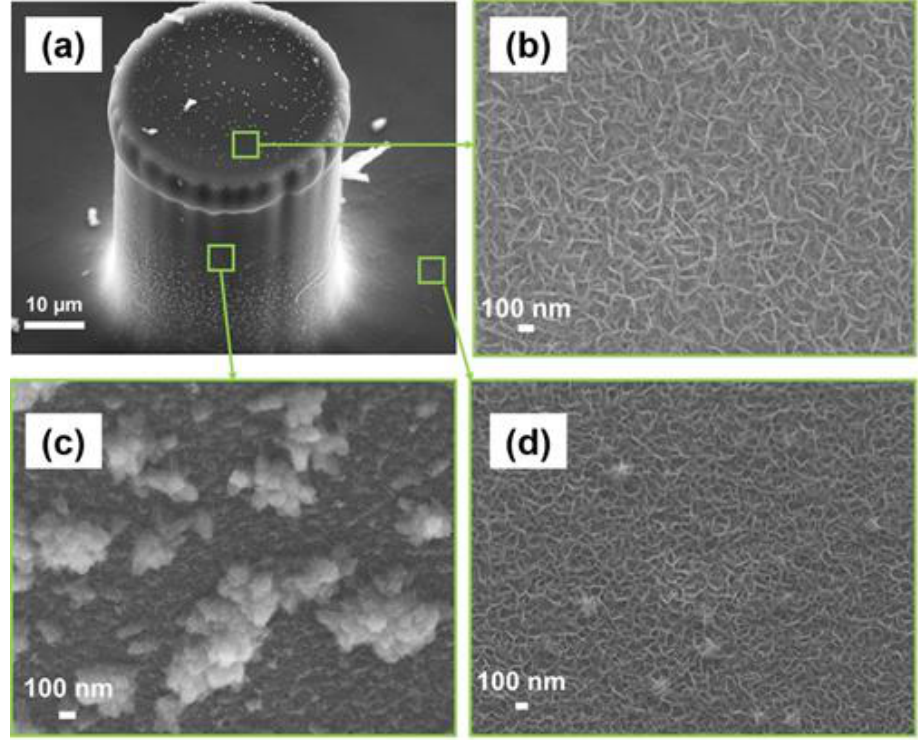
Figure 3. SEM images of ( a ) C-MEMS micro pillars with BPE-rGO, ( b ) BPE-rGO deposition on top of the micropillar, ( c ) BPE-rGO deposited on sides of the micropillar, and ( d ) BPE-rGO deposited on thin film base electrode.